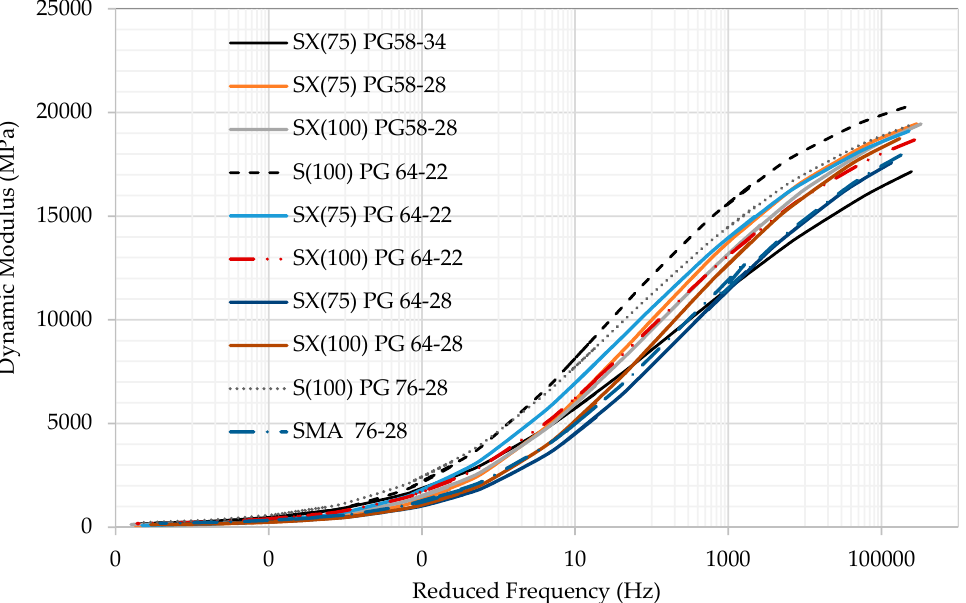
Figure 1. Groupwise comparison in a semi-log graph.